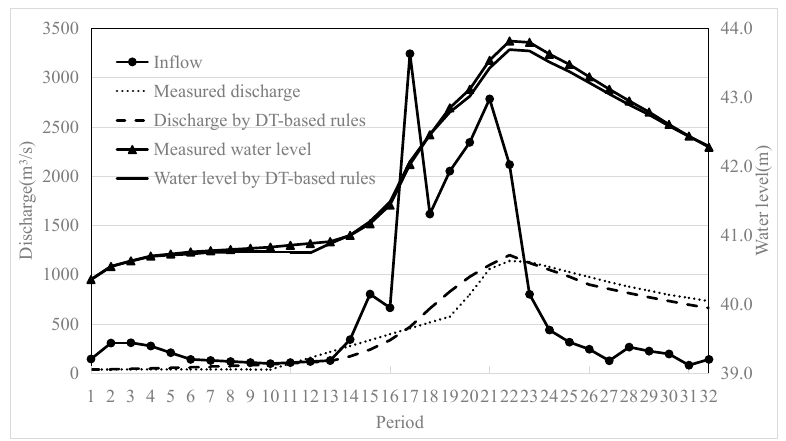
Figure 3. Operation hydrographs for 12 Aug 2019.